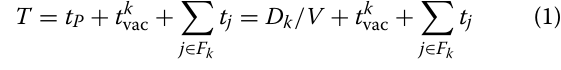
returns to O . This problem is defined as the traveling salesman problem (TSP) [13]. In TSP, the shortest path which connects all the nodes in S and has the shortest overall length is called the shortest Hamiltonian cycle.